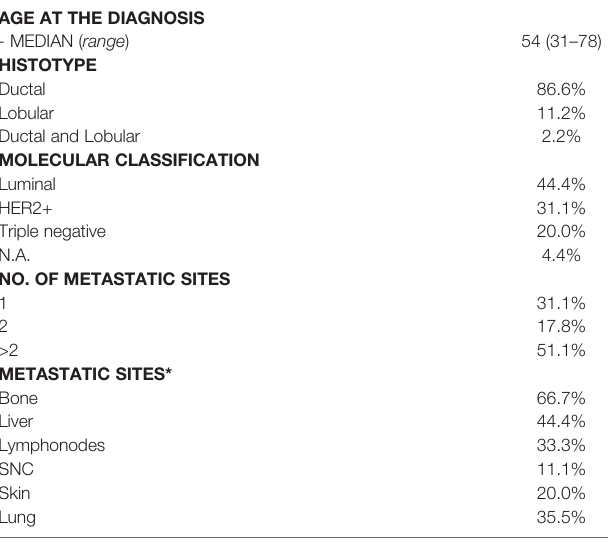
TABLE 1 | Demographic and clinicopathological features of the 45 MBC patients analyzed. AGE AT THE DIAGNOSIS - MEDIAN ( range )